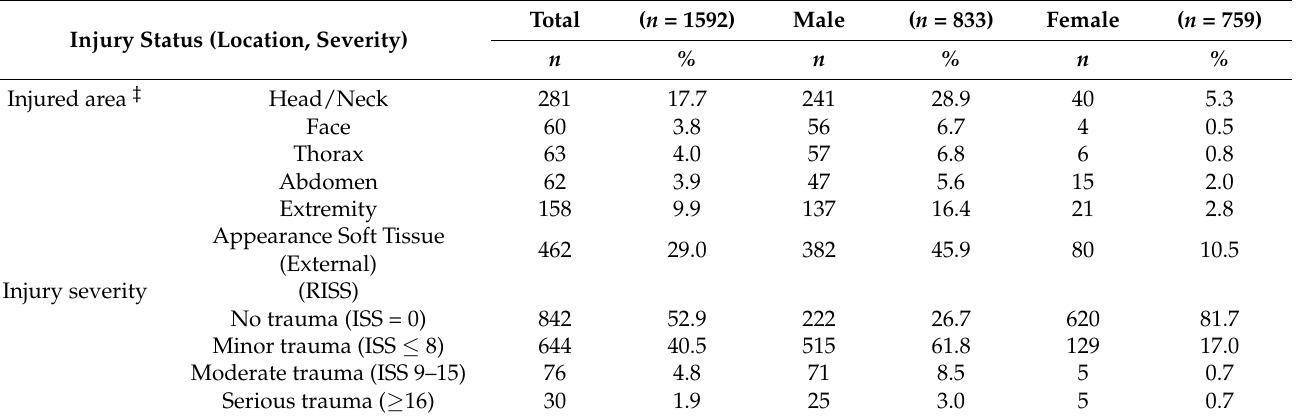
Table A2. Injured Site, Injury Severity (RISS) of Violently Abused Children.